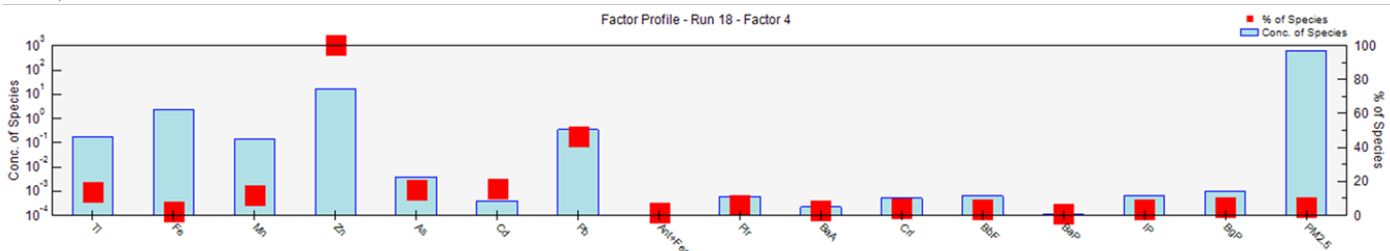
Figure 3. Pollutants concentration and percentage for each identified factor: a) “coke ovens”; b) “homogenization process/mineral park”; c) ”traffic”; d) ”sintering”.